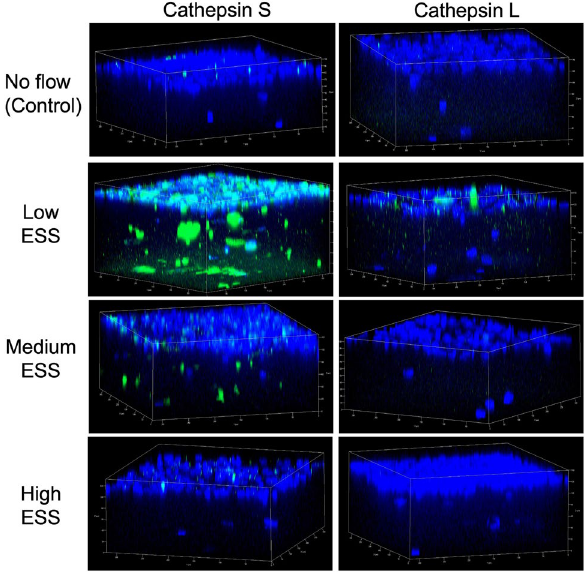
Figure 4. Effect of various shear stress conditions on the cathepsin protein expression in the co-cultured models. 3D co-culture of HCAECs, HCASMCs, and monocytes (THP-1) cells were prepared on the cover slips and exposed to low ESS, medium ESS, high ESS, or no flow (control) for 1 h followed by additional culture for 5 h. Immunofluorescence staining was performed as described in the “Methods”. ESS: endothelial shear stress.